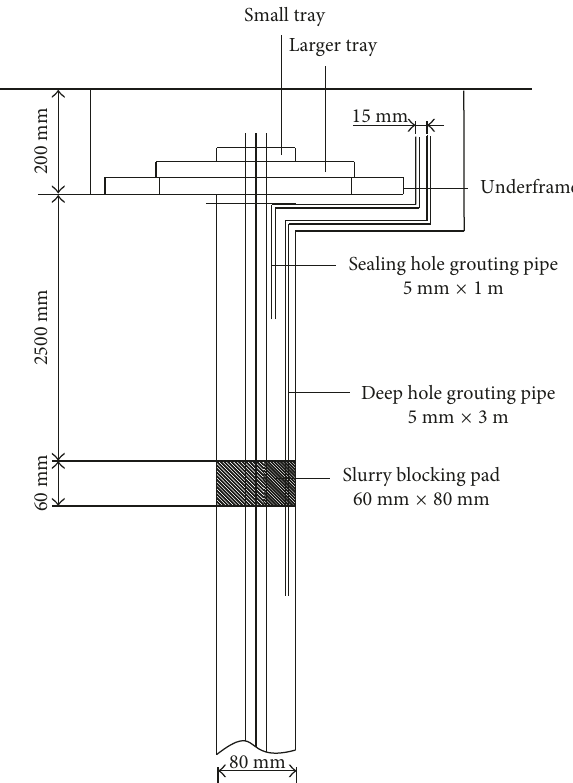
Figure 8: Illustration of combined grouting anchor structure.